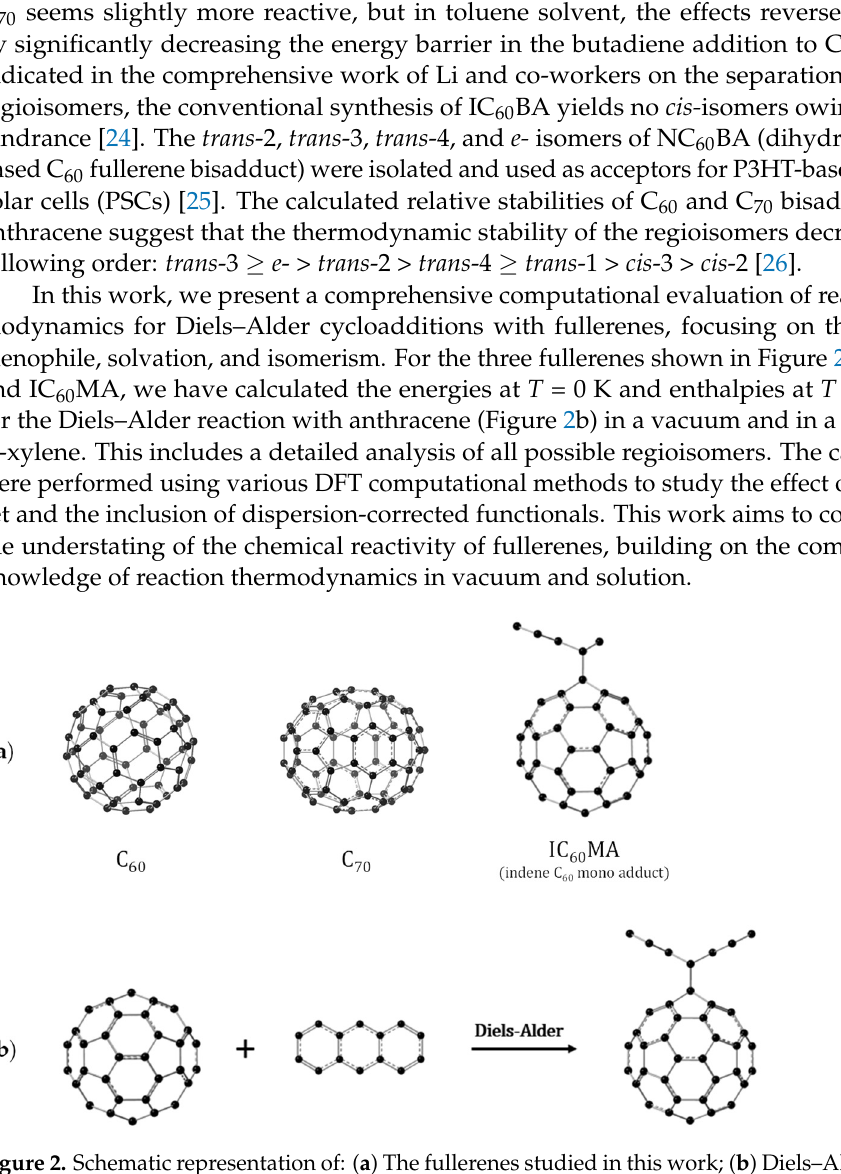
Figure 2. Schematic representation of: ( a ) The fullerenes studied in this work; ( b ) Diels–Alder reaction between the fullerenes and anthracene.